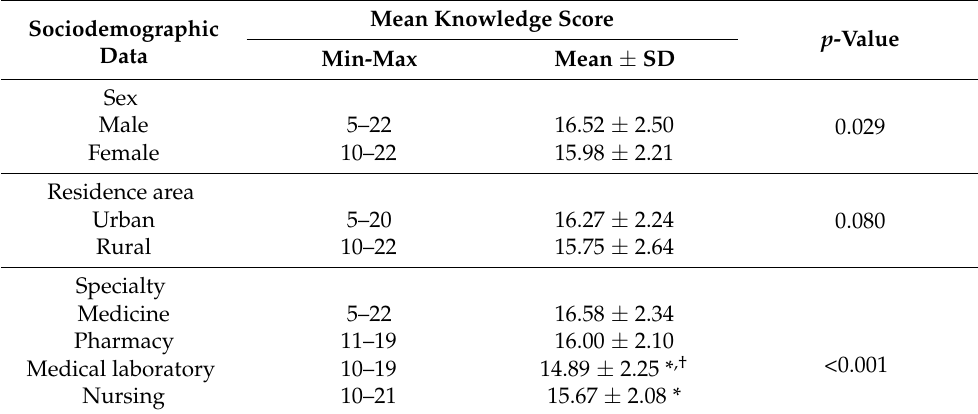
Table 5. Relationship between sociodemographic of the participants and their mean knowledge score about